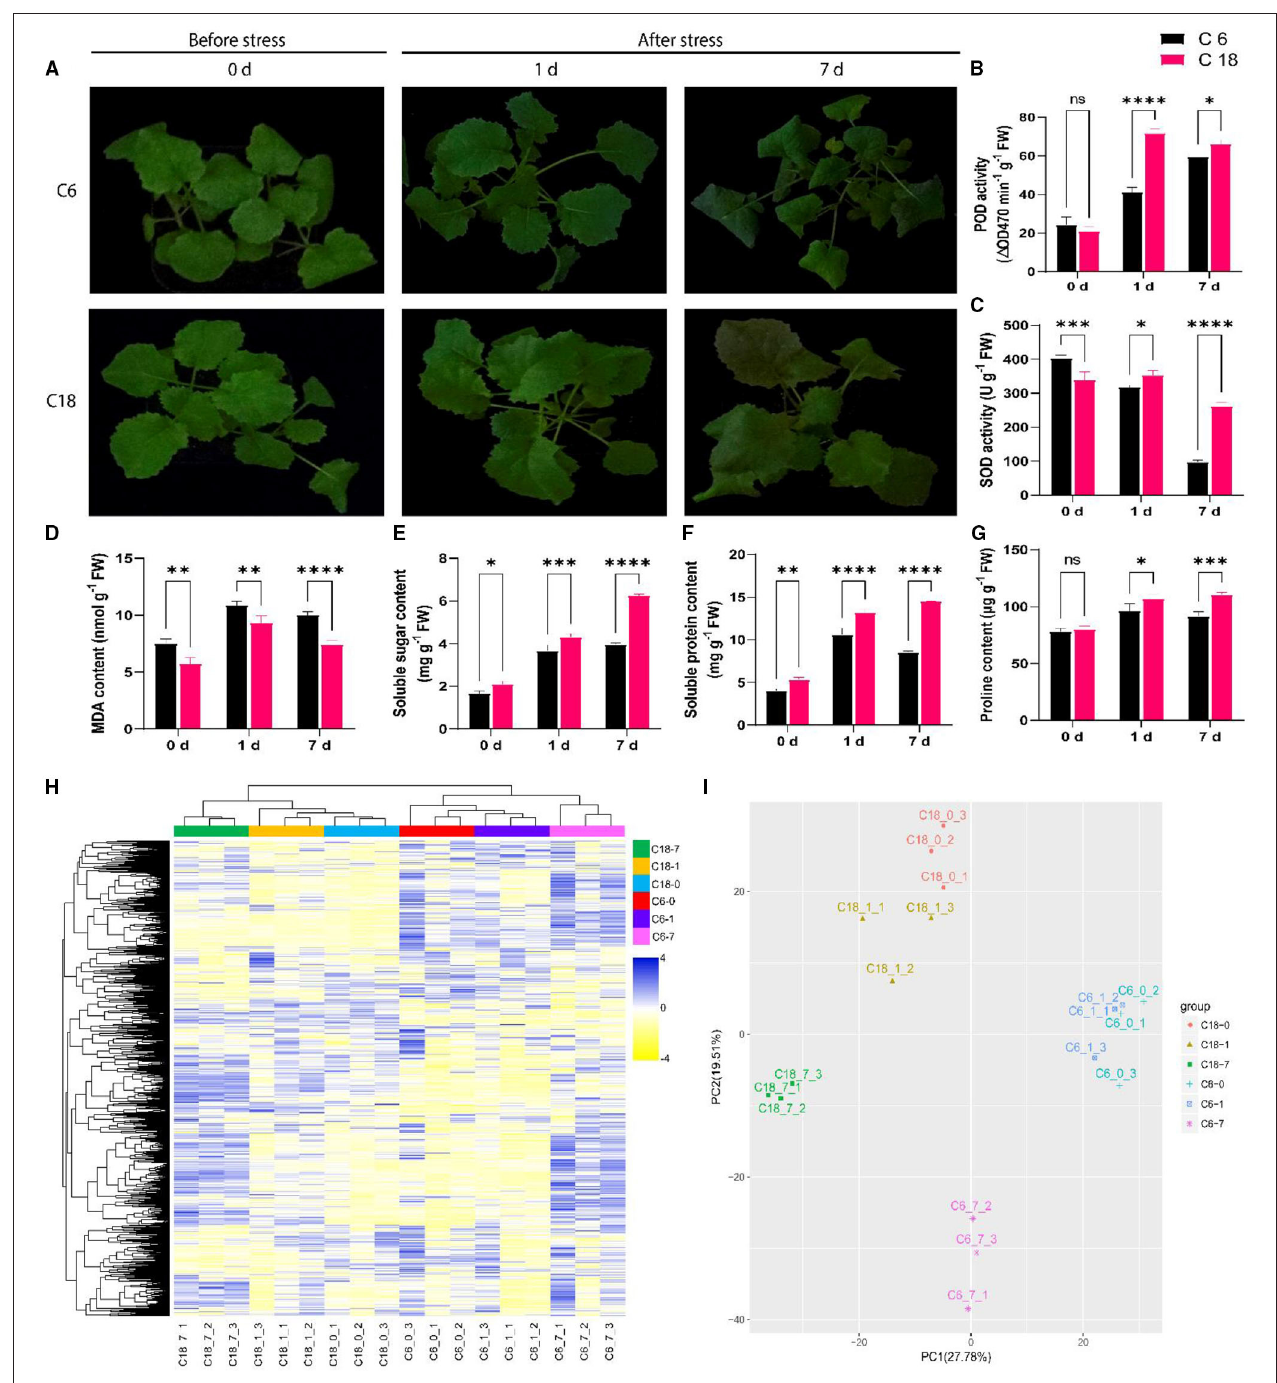
FIGURE 1 | Physiological and metabolic profiling of cold-tolerant (C18) and cold-sensitive (C6) rapeseed varieties responding to cold stress (4 ◦ C) at 0 days (CK), 1 day after stress, and 7 days after stress. (A) Phenotypic evaluation of C18 and C6; (B–G) Physiological responses including (B) peroxidase (POD) activity, (C) superoxide dismutase (SOD) activity, (D) malondialdehyde (MDA) content, (E) soluble sugar content, (F) soluble protein content, and (G) proline content. Error bars represent SD ( n = 3). The statistical significance was determined via a two-way ANOVA and Dunnett’s multiple comparisons test with **** p < 0.0001, *** p ≤ 0.001, ** p ≤ 0.01, * p ≤ 0.05, and ns mean non-significant. (H) The unsupervised hierarchical cluster analysis for untargeted metabolomic profiles. The dendrogram was built based on the fold change ( P < 0.05, VIP > 1 and log 2 FoldChange > 1.5) heatmap. The rows in the heatmap indicate metabolites, and the columns represent groups/samples. The colors of the heatmap cells represent the scaled expression level of metabolites among the different groups. The color gradient, ranging from blue to yellow through white, indicates the low, high, and middle values of metabolite expression. The colors of the different groups represent the biological replicates at three different time points for two genotypes, while 0 (CK), 1, and 7 days represent the sample collection time points after the treatment. (I) Principal component analysis (PCA) based on metabolomic data. The X-axis represents the first principle component (PC1), and the Y-axis represents the second principal component (PC2).